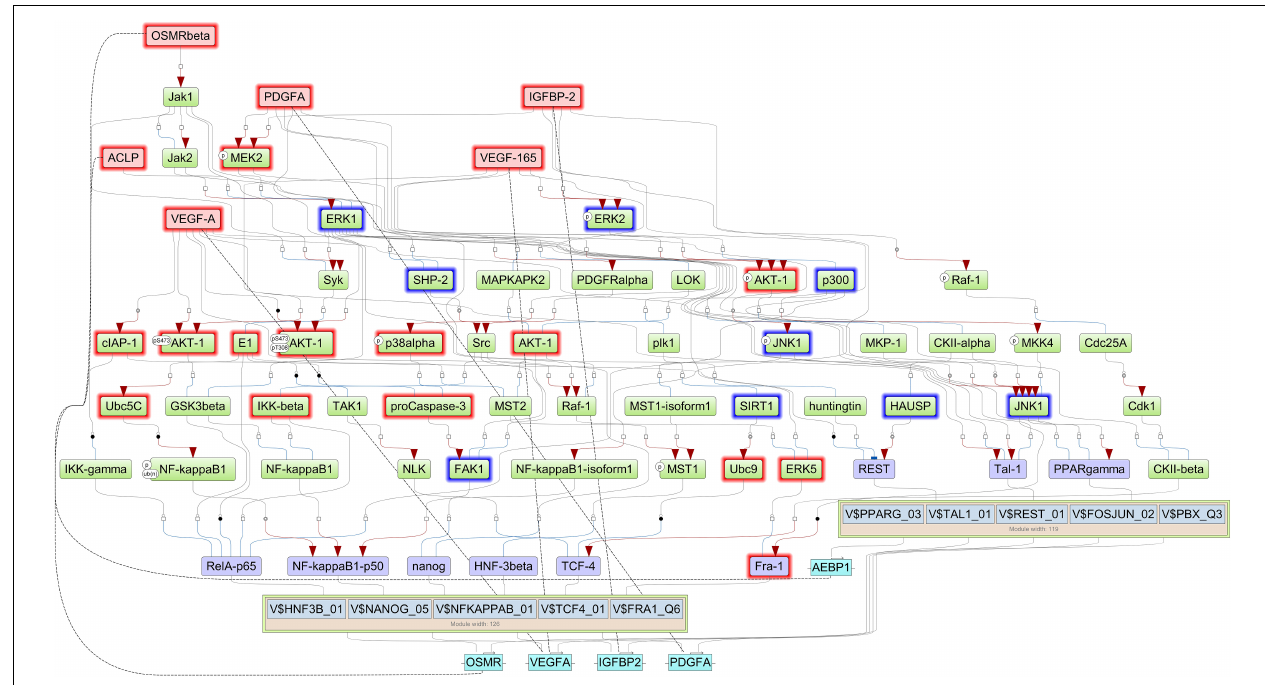
FIGURE 3 | Signal transduction and gene regulatory network of six master regulators (red nodes) regulating two transcription factor modules (purple nodes) enriched in promoters of highly upregulated genes of short-term survivors (STS). The dotted lines from genes to such signaling proteins represent the transcription and translation processes (positive feedback loops). The outside box filling is based on log2FC < ( − 0.2) and is filled red when upregulated (log2FC > 0.2 and p -value < 0.05) and filled blue when downregulated (log2FC < 0.2 and p -value < 0.05) in the current study.